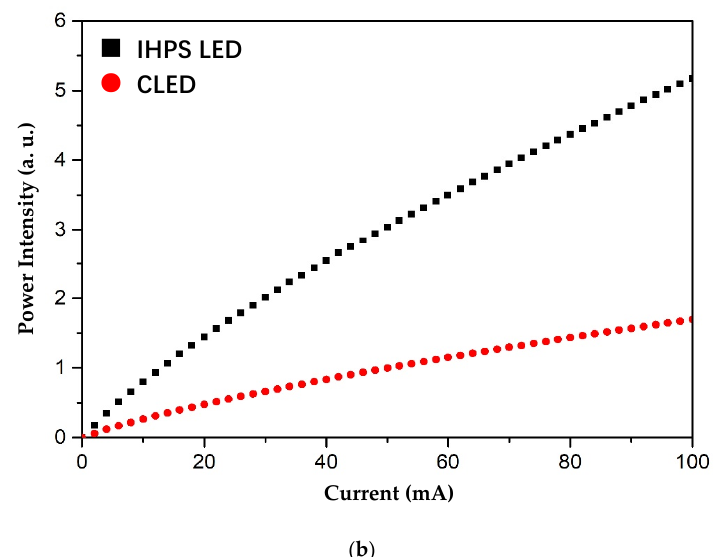
Figure 4. ( a ) Cross-sectional top-view FESEM image showing the surface morphology of the p-GaN layer after being baked at 240 °C and etched. ( b ) Power intensities of the common LED (CLED) and the IHPS LED.